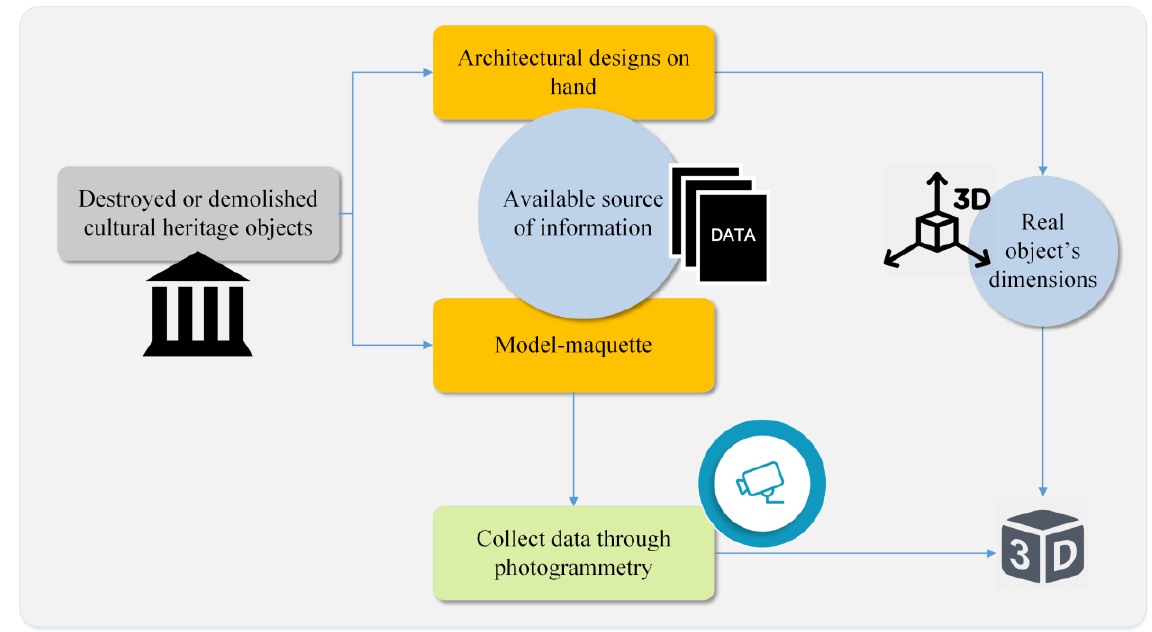
Figure 4: Workflow of the 3D representation of cultural heritage structures that does not exist